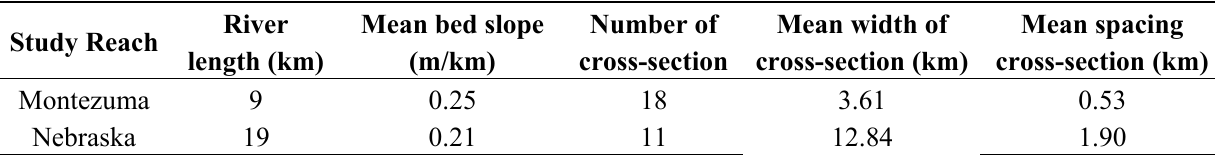
Table 1. Geo-morphological properties of the two selected river reaches for hydraulic